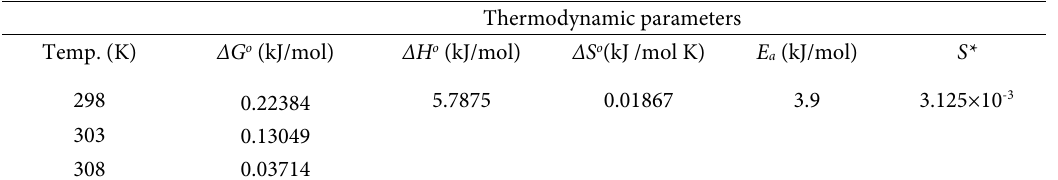
Table 4. Values of thermodynamic parameters